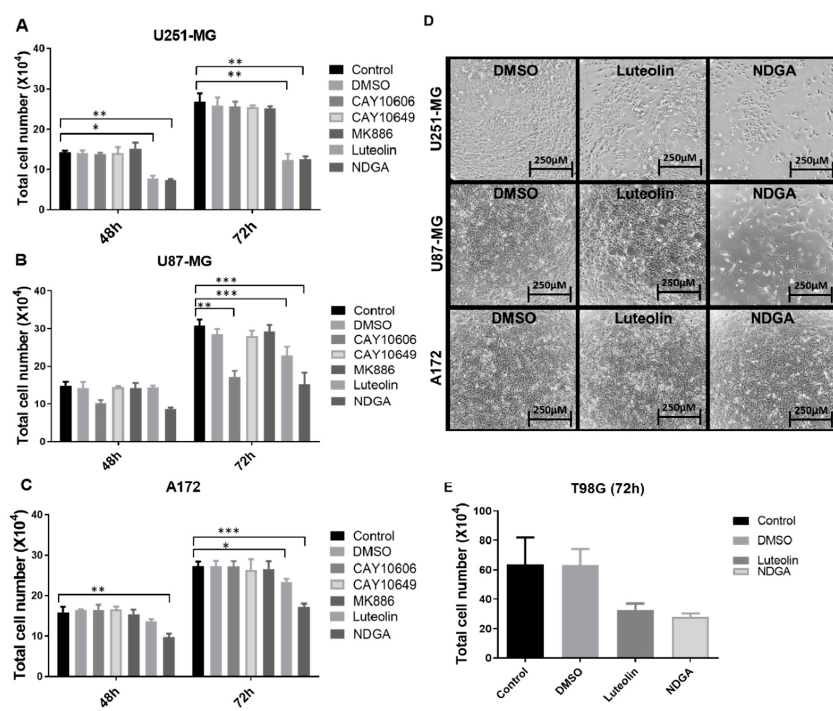
Figure 4. Treatment with the inhibitors luteolin, NDGA, CAY10606, CAY10649, MK886,